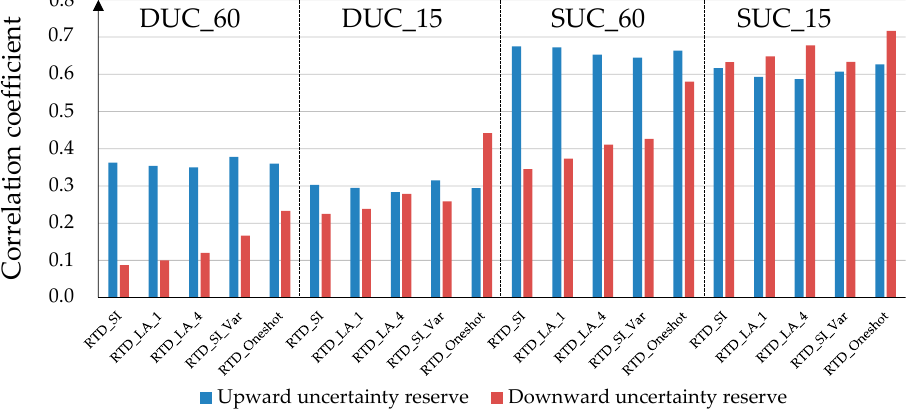
Figure 4. Correlation between procured and deployed uncertainty reserves by the eligible units.